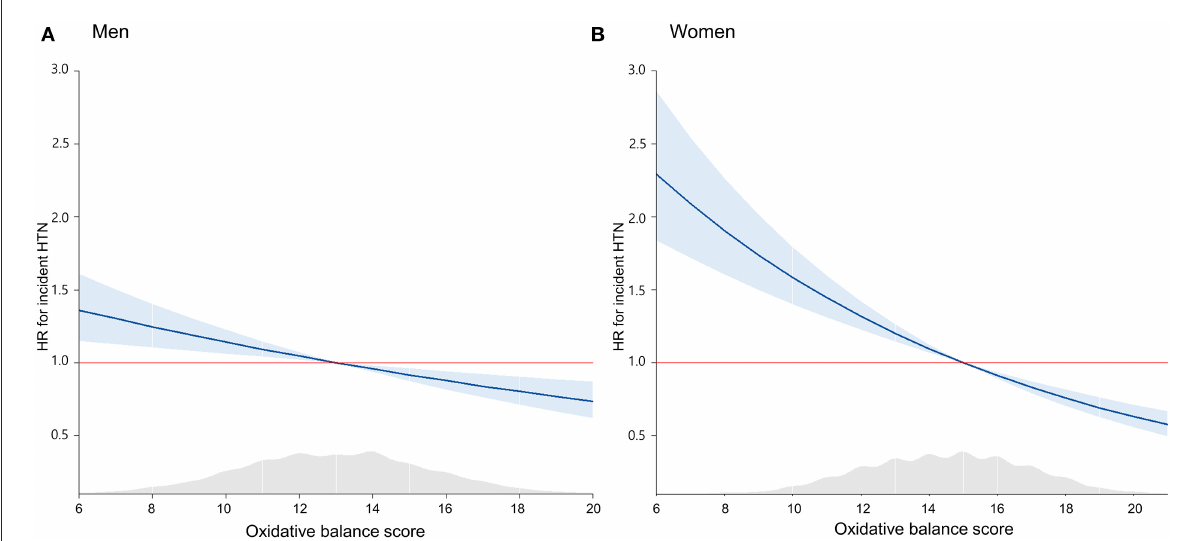
FIGURE3 Spline curve for the cox proportional hazard model of incident HTN by sex-specific OBS in (A) men and (B) women. HTN, hypertension; OBS, oxidative balance